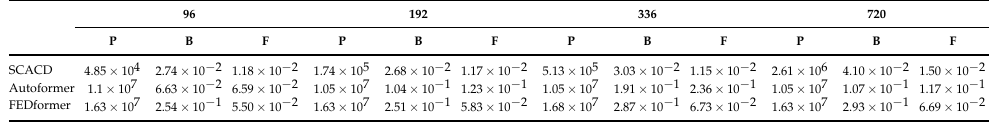
Table 4. The values correspond to the prediction scales. The hyperparameters are set as in Section 4.1. P: the number of the parameters; B: time (s/batch) for the backward; F: time (s/batch) for the forward. 96 192 336